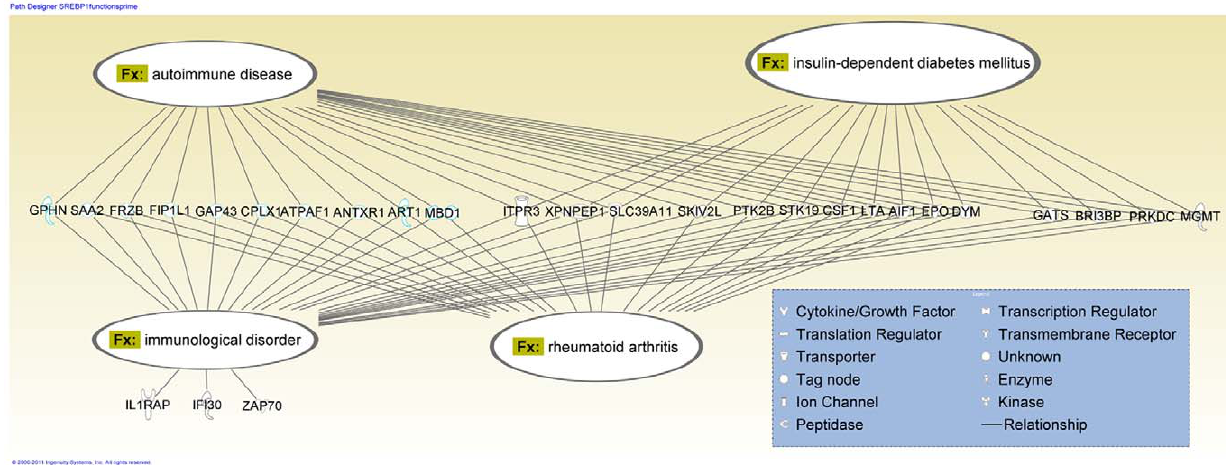
Figure 7. Analysis of SREBP1 gene network for disease functions.